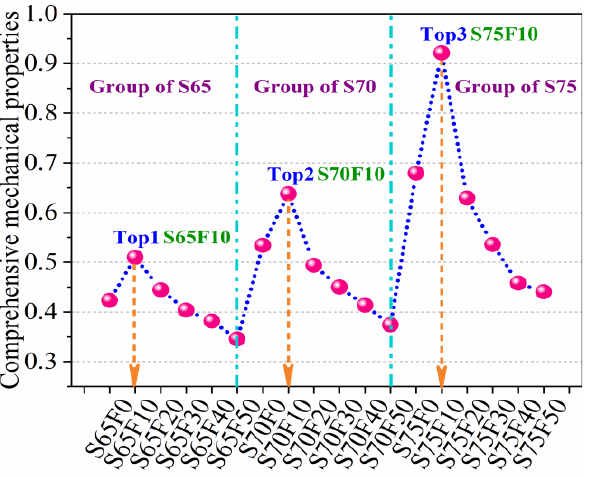
Figure 16. Comprehensive mechanical properties of specimens.